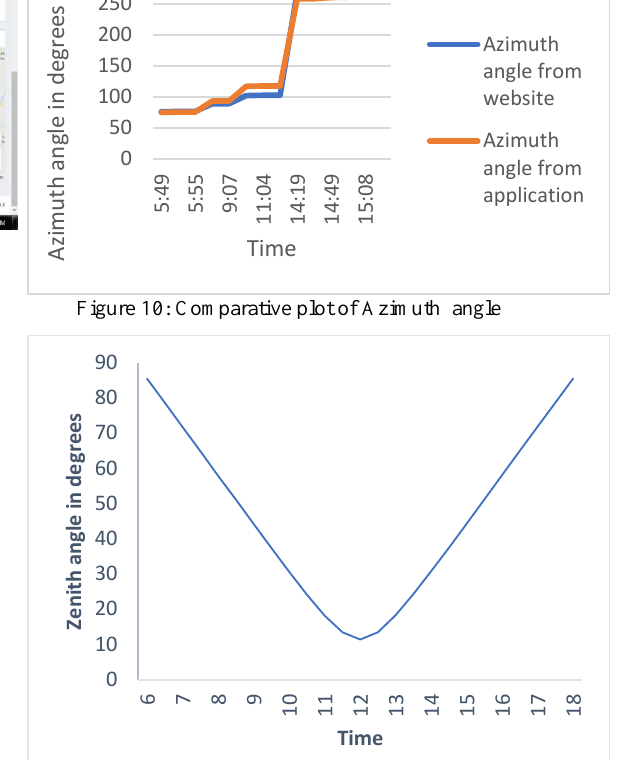
Figure 9: Comparative plot of Zenith angle